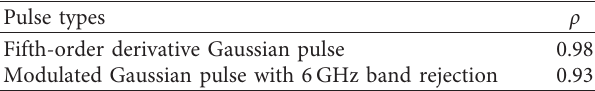
Table 4: Correlation factors ( ρ ) between the amplitudes of input and radiated signals. Pulse types Fifth-order derivative Gaussian pulse Modulated Gaussian pulse with 6GHz band